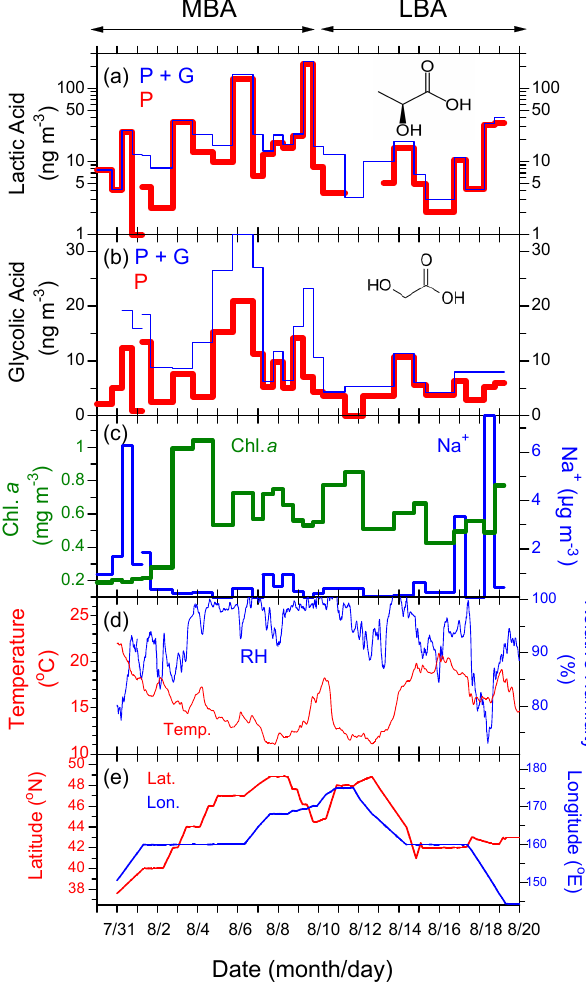
Figure 1. Time series of the concentrations of (a) lactic acid and (b) glycolic acid in the particle ( p ) phase and the sum of gas and par- ticle ( g + p ) phases, (c) Chl a concentrations in seawater and Na + concentrations in aerosols, (d) ambient temperature and relative hu- midity, and (e) the ship position (latitude and longitude) during the R/V Hakuho-Maru cruise. See the text for the definition of MBA (30 July–7 August 2008) and LBA (9–19 August 2008) periods. The y axis of (a) is plotted on a log scale.